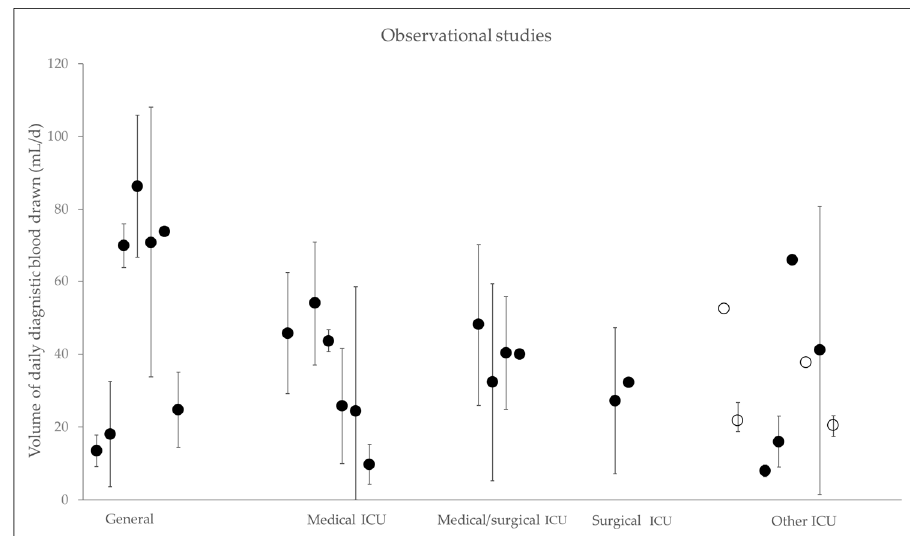
Figure 3. Observational studies. Daily diagnostic blood drawn in mL/d, clustered into types of ICU. Black dots show mean with standard deviation and white spots show median with interquartile range. References corresponding to Table 3: General ICU [1,9,10,46,49,50,60]; Medical ICU